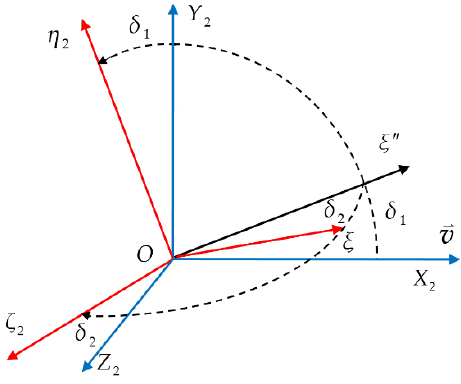
Figure 1. The angular relationships between these coordinate systems.